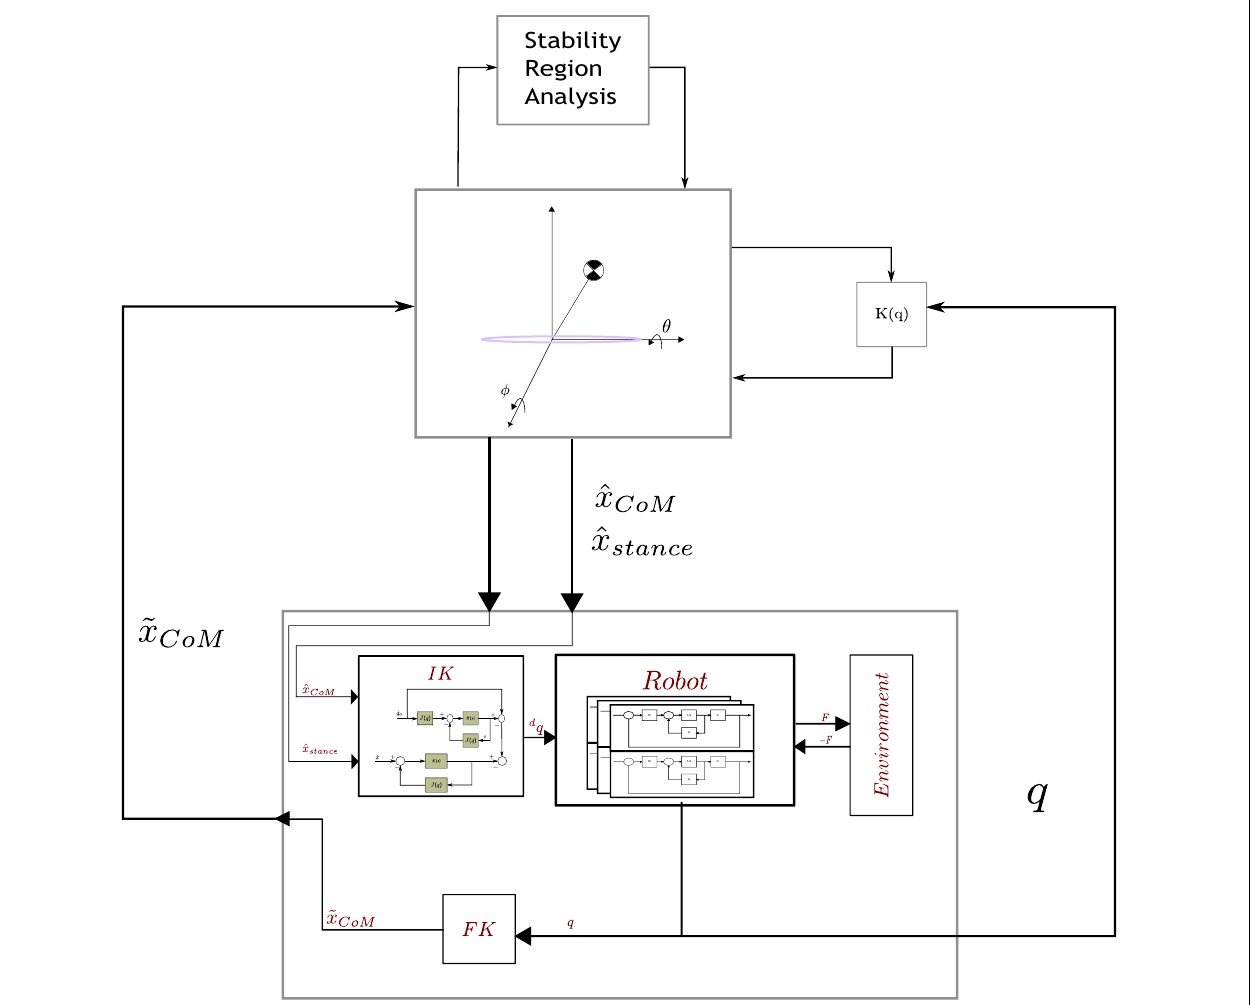
FIGURE 9 | Complete control framework for standing balance and walking gait generation . The diagram shows how the SIP model and the energy-based controllers are used as an internal control loop that provides CoM and foot trajectories to the humanoid robots while receiving the actual CoM and feet location in the feedback